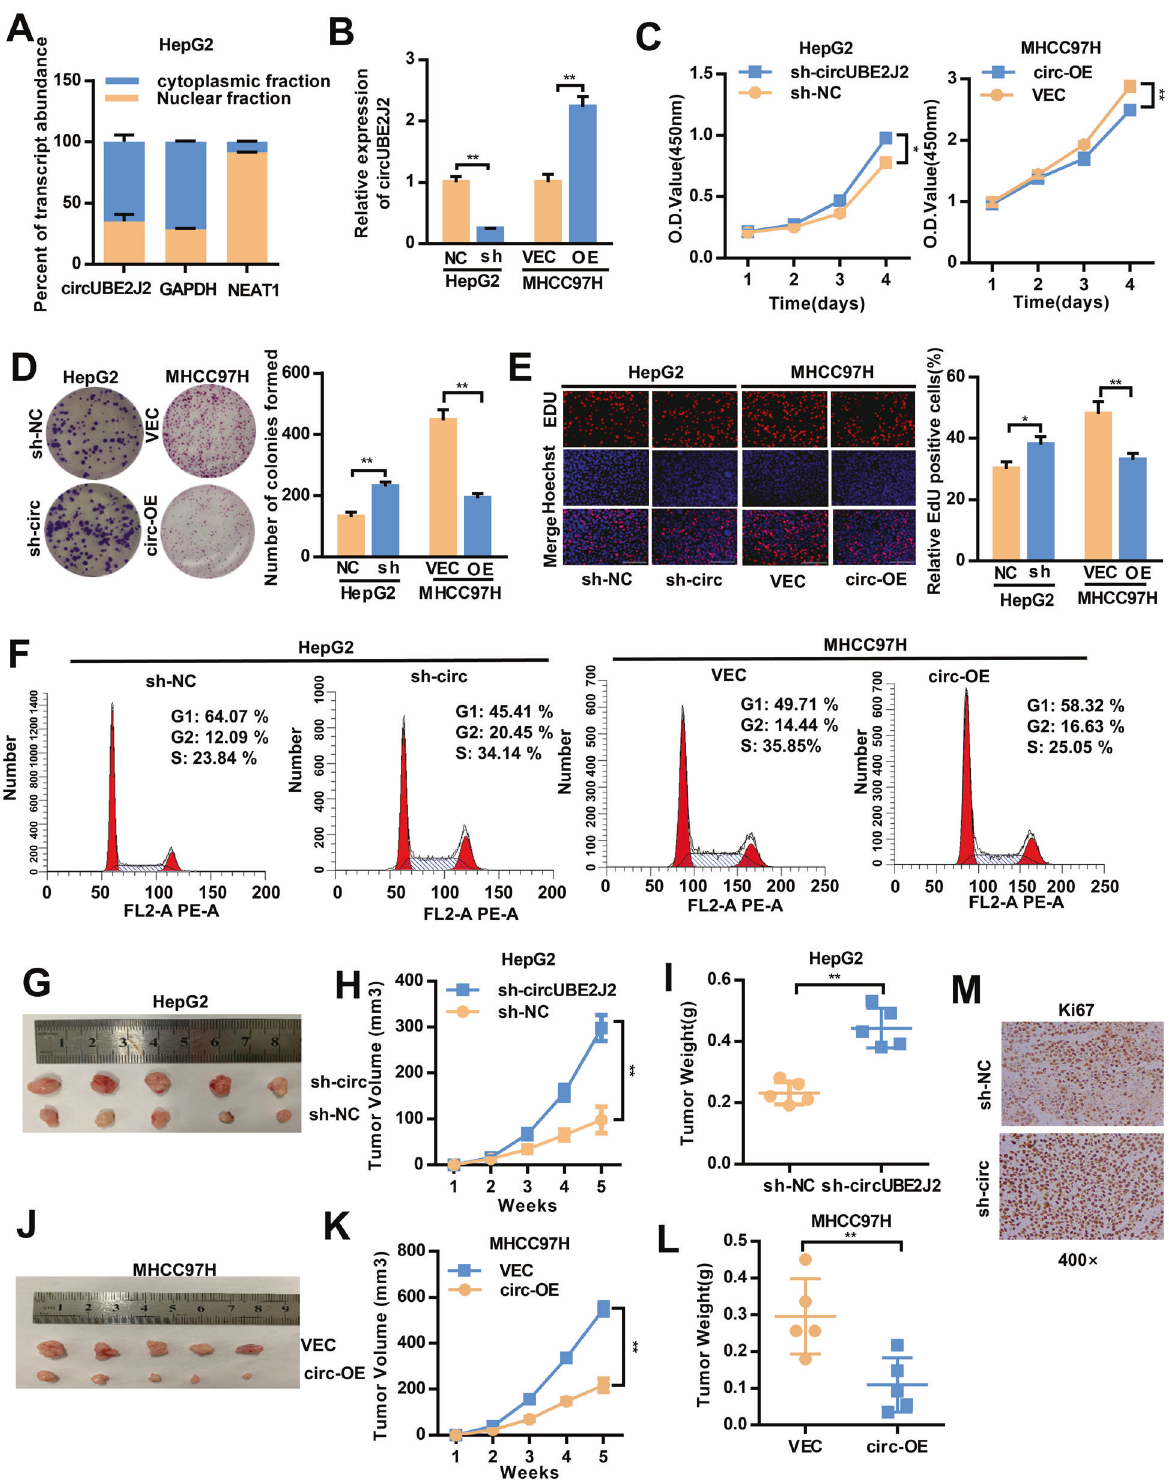
Fig. 2 Decrease of circUBE2J2 expression promoted the proliferation of HCC cells in vitro and in vivo. A The expression level of circUBE2J2 in the subcellular fractions of HepG2 cells was detected by qRT-PCR. NEAT1 and GAPDH were used as nuclear and cytoplasmic markers, respectively. B The overexpression and knockdown ef fi ciency of circUBE2J2 were examined by qRT-PCR. C – E CCK-8 ( C ), colony formation assay ( D ), and EDU ( E ) were used to evaluate HCC cells proliferation after circUBE2J2 overexpression or knockdown. Scale bar: white bar, 200 μ m. F Flow cytometry detection showing the percentages of cells in the G1, S, or G2 phase in both HepG2 and MHCC97H cells. G – L HCC cells were subcutaneously injected into nude mice, and tumor growth curves and tumor volume were plotted. Data are presented as mean ± SD; ** p < 0.05; ** p < 0.01; vs. NC. M Expression levels of Ki67 were observed in subcutaneous tumor tissues by IHC. The data are represented as the mean ± SD, n = 3. * p < 0.05; ** p < 0.01; NS no signi fi cance. OE overexpression; sh-circ transfected with lentivirus for circUBE2J2-speci fi c shRNA; sh-NC transfected with control